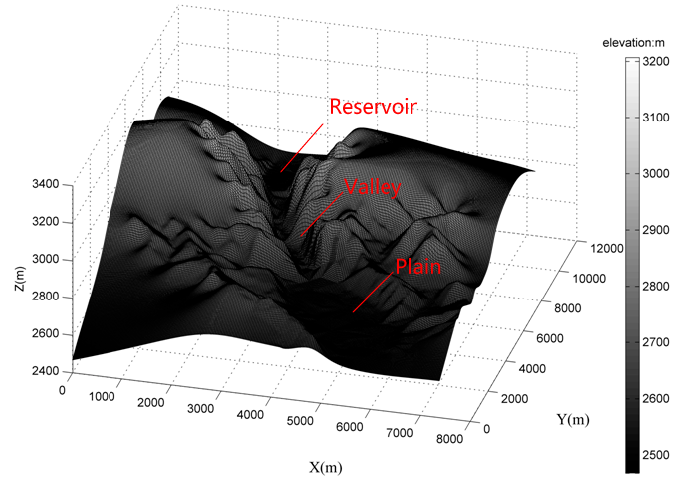
Figure 14. 3D topographic map for SWE-SPH model input.